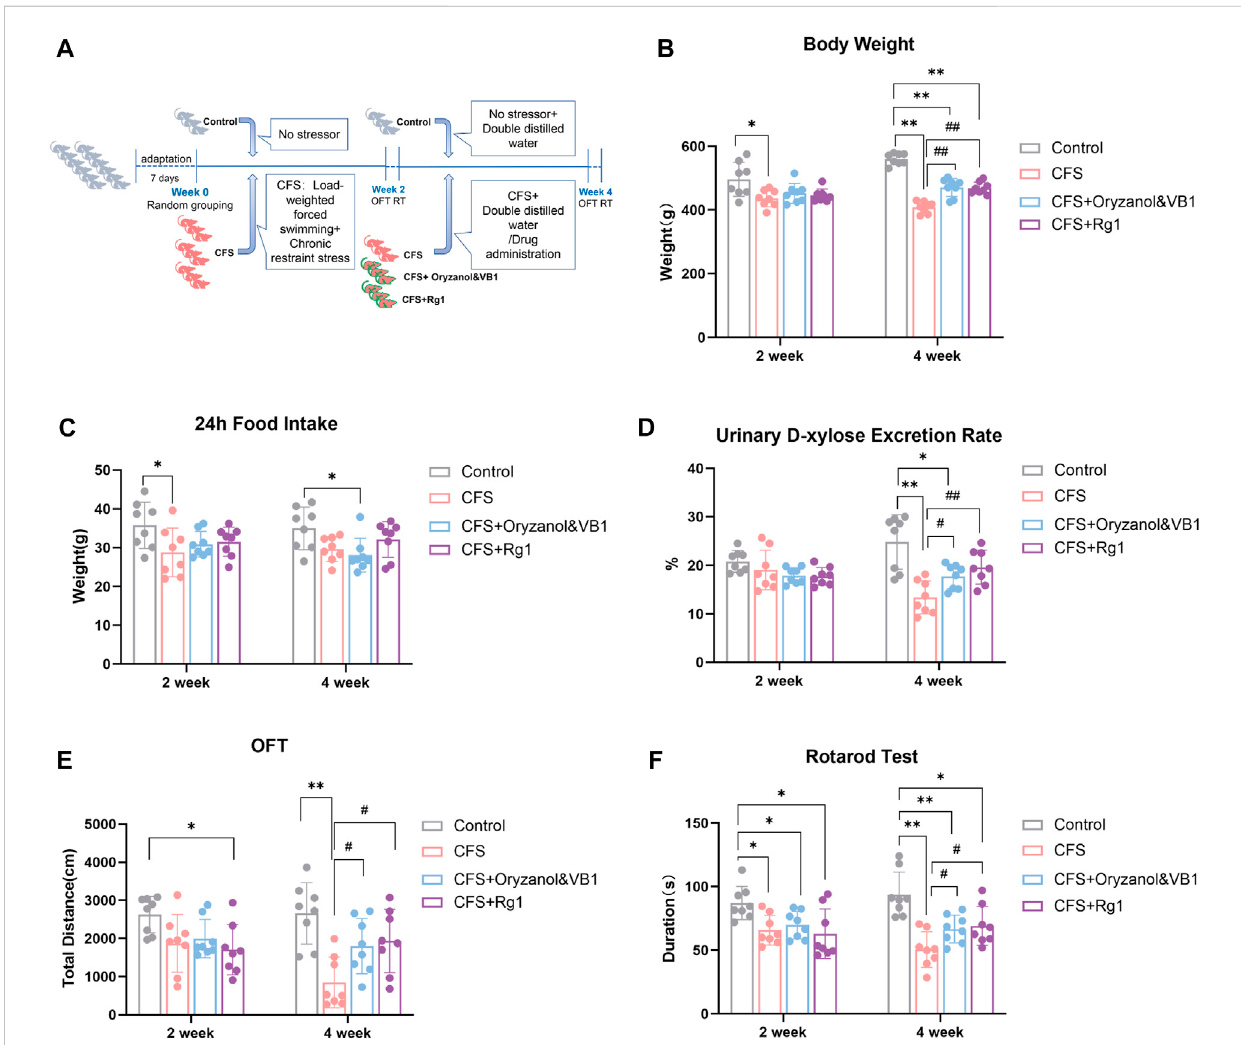
FIGURE 1 (A) Experimental procedure implemented for a CFS rat model. (B) Body weight changes in the four rat groups. (C) 24-h food intake of the four rat groups. (D) 24-hurinaryD-xyloseexcretionrateinthefourratgroups. (E) TotaltraveldistanceofthefourratgroupsintheOpenFieldTest. (F) Timespent on the rod in the four rat groups (Rotarod Test). Data are shown as the mean ± standard deviation, n = 8. * p < 0.05, ** p < 0.01 versus control group; # p < 0.05, ## p < 0.01 versus CFS